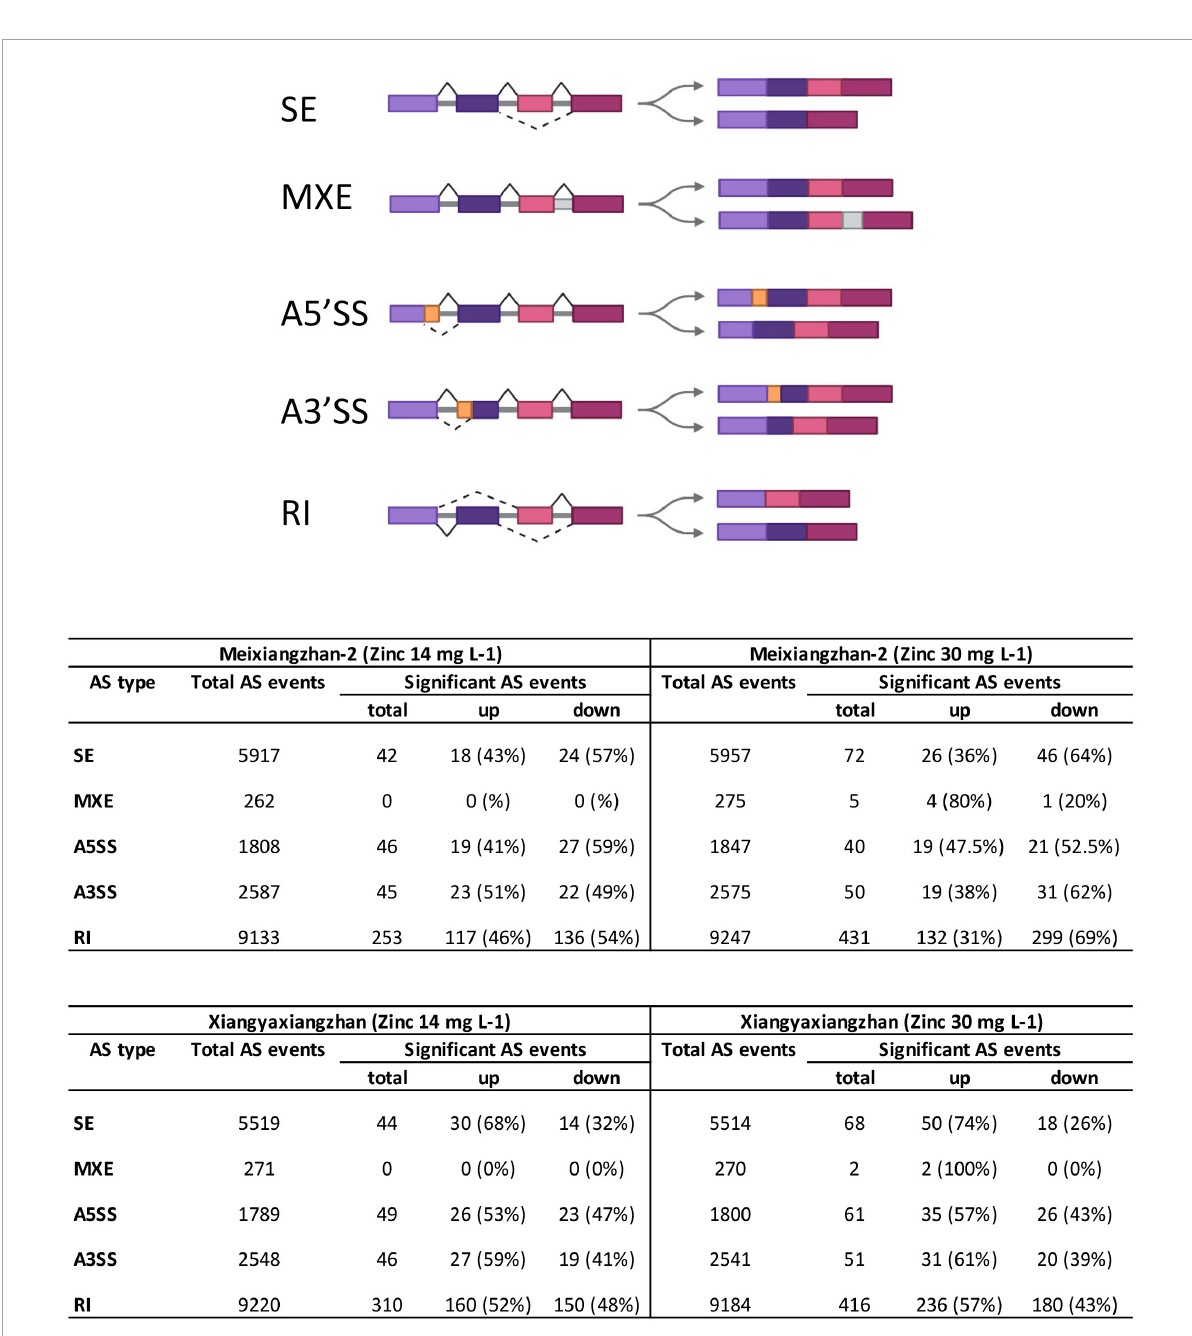
FIGURE1 The number of all types of alternative splicing (AS) events in Meixiangzhan-2 and Xiangyaxiangzhan cultivars in response to different levels of Zn treatment. An overview of 5 different types of AS is presented at the top (created with Biorender). SE, skipped exon; MXE, mutually exclusive exons; A5SS, alternative 5 (cid:48) splice site; A3SS, alternative 3 (cid:48) splice site; RI, retained